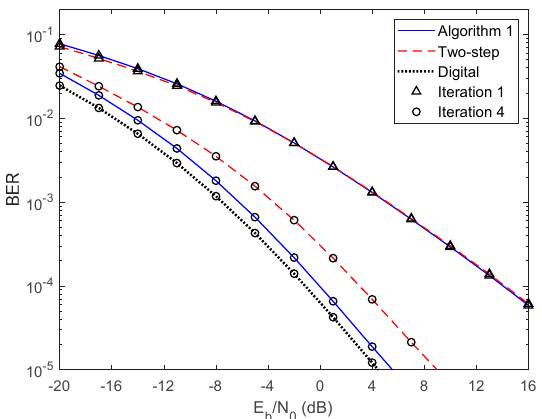
Figure 12. Performance comparison between the Algorithm 1 and the two-step approach for the PCSI precoder with ULA configuration, path loss, and shadowing and QPSK modulation.